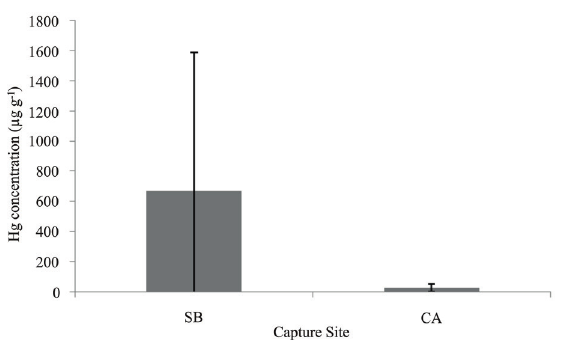
Figure 2 - Total Hg content (µg g -1 dry weight ± SD) in the fur of jaguars by capture site. Here, SB = Fazenda São Bento (n = 4 individuals); CA = Refúgio Ecológico Caiman (n = 5